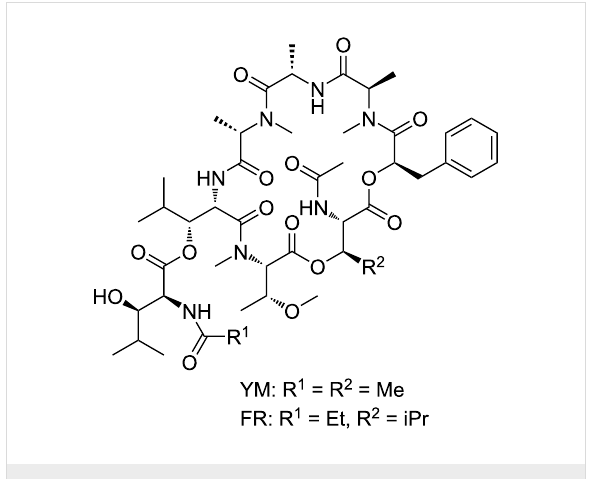
Figure 1: Natural products YM-254890 and